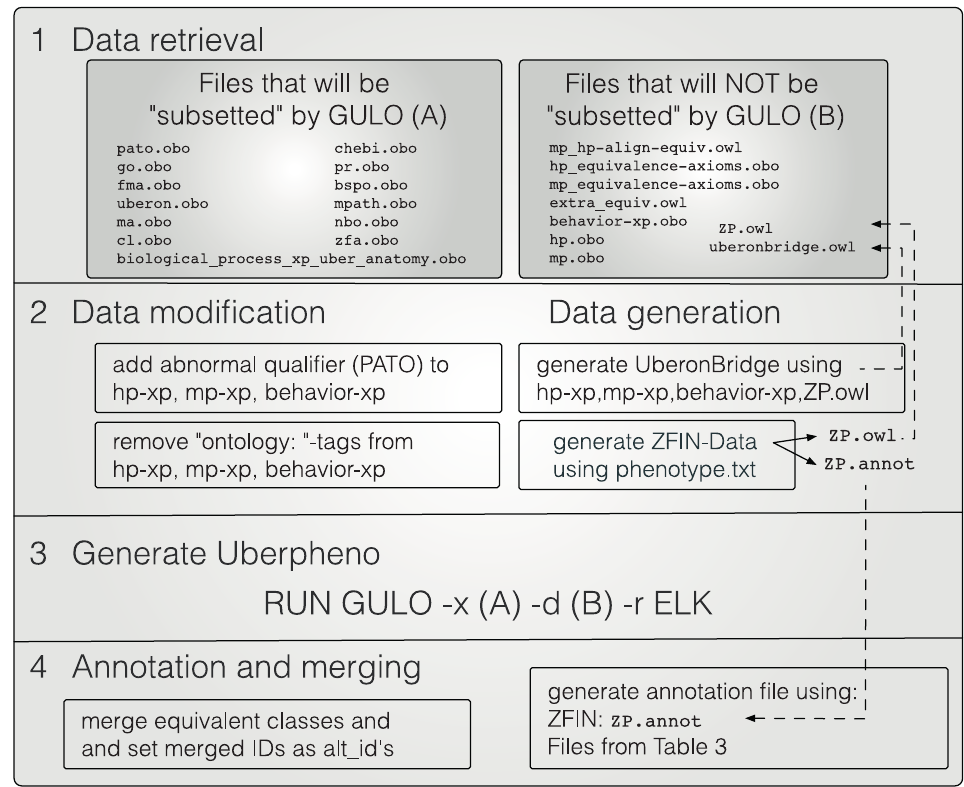
Figure 2. Schematic work- and dataflow illustration for the construction of the Uberpheno ontology and the gene